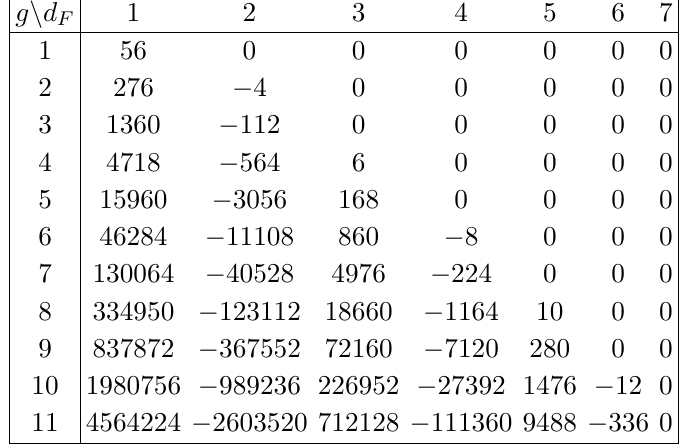
with base class (cid:12) = B 4